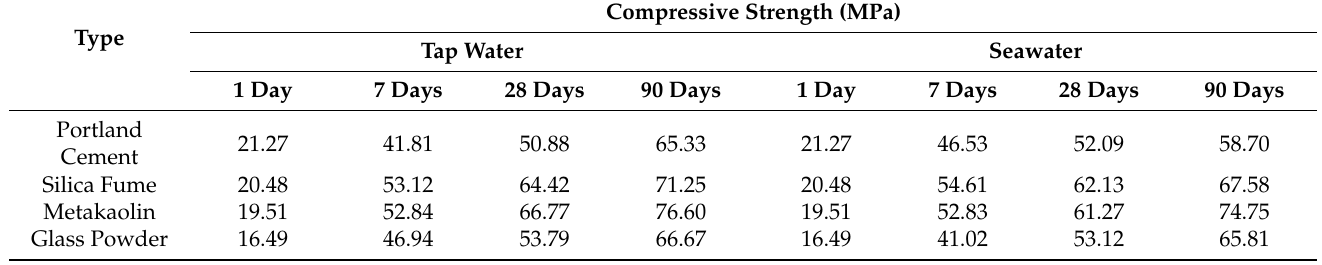
Figure 6. Representative failure modes of samples after 28 days compressive strength measurement: ( a ) neat PC; ( b ) PCM containing silica fume; ( c ) PCM containing metakaolin; ( d ) PCM containing class powder.